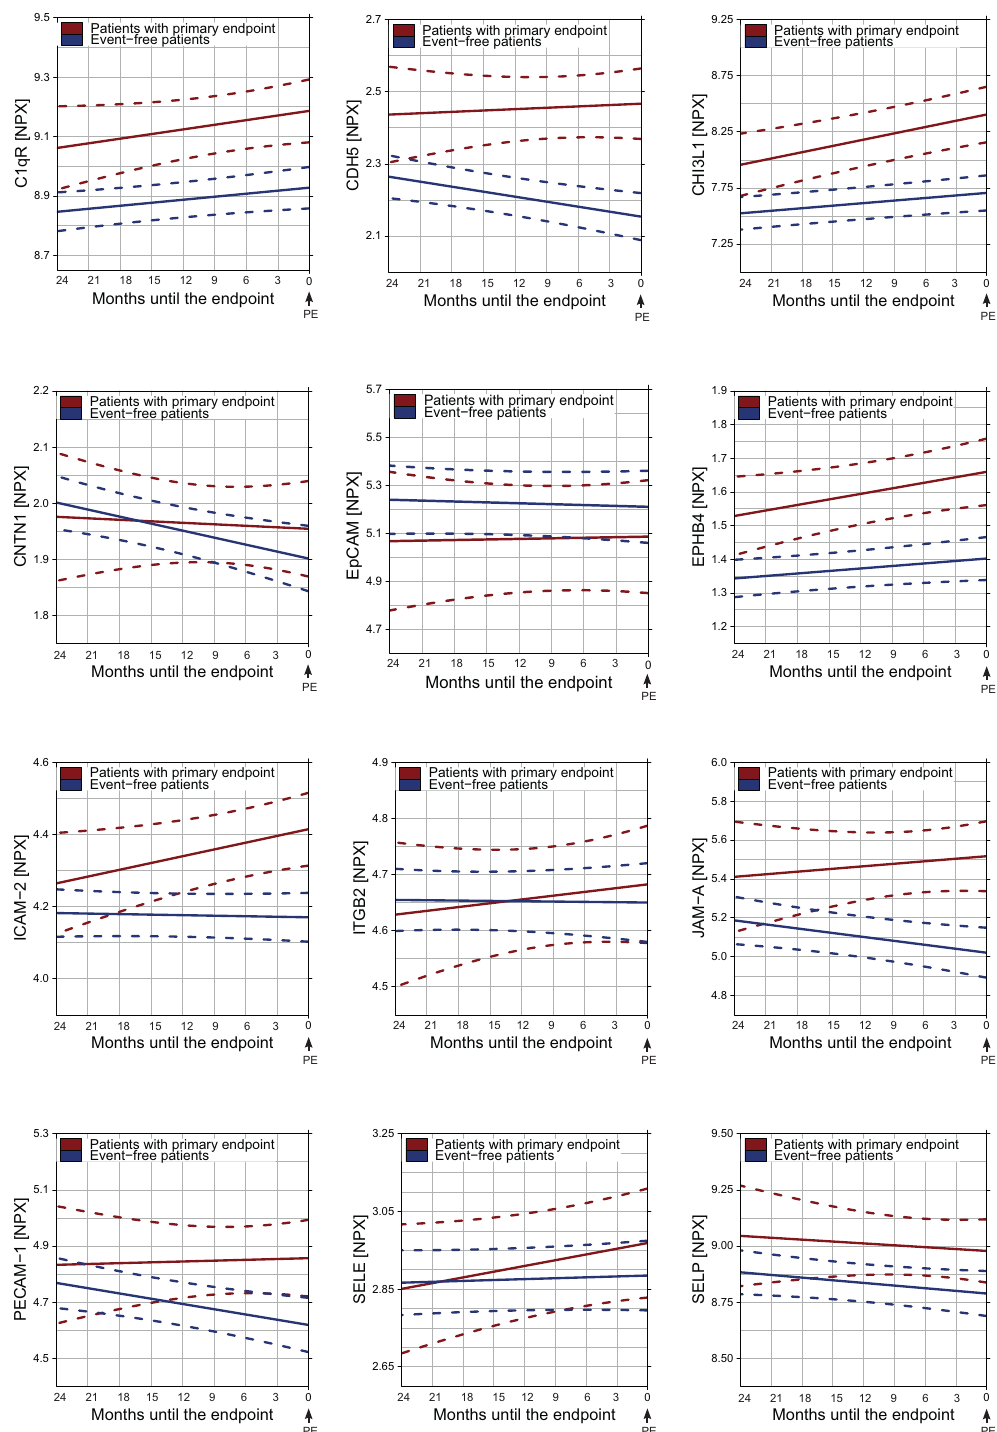
Figure 1. Average temporal patterns of adhesion molecule biomarkers during follow-up approaching the primary endpoint (PE) or last sample moment. X -axis: time remaining to the PE (for patients who experienced incident adverse events) or time remaining to last sample moment (for patients who remained event-free). Therefore, ‘time zero’ is defined as the occurrence of the endpoint or last sample moment and is depicted on the right side of the x-axis, so that the average marker trajectory can be visualized as the endpoint approaches. Y -axis: biomarker levels in arbitrary, relative units (Normalized Protein Expression, NPX). Solid red line: Average temporal pattern of biomarker levels in patients